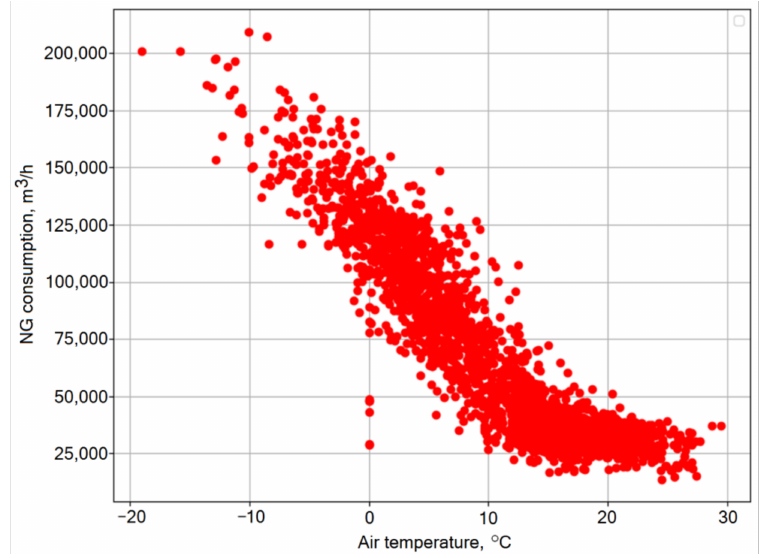
Figure 5. The dependence of total natural gas consumption on